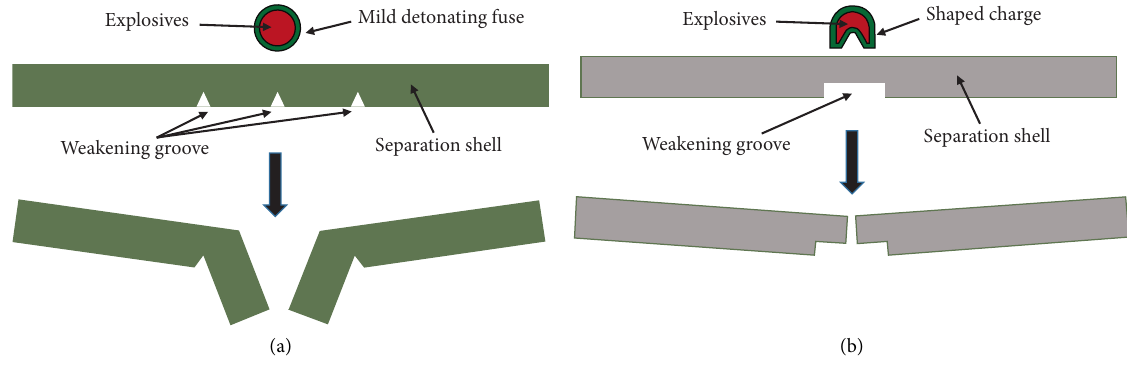
Figure 1: Separation structure: (a) mild detonating fuse; (b) shaped